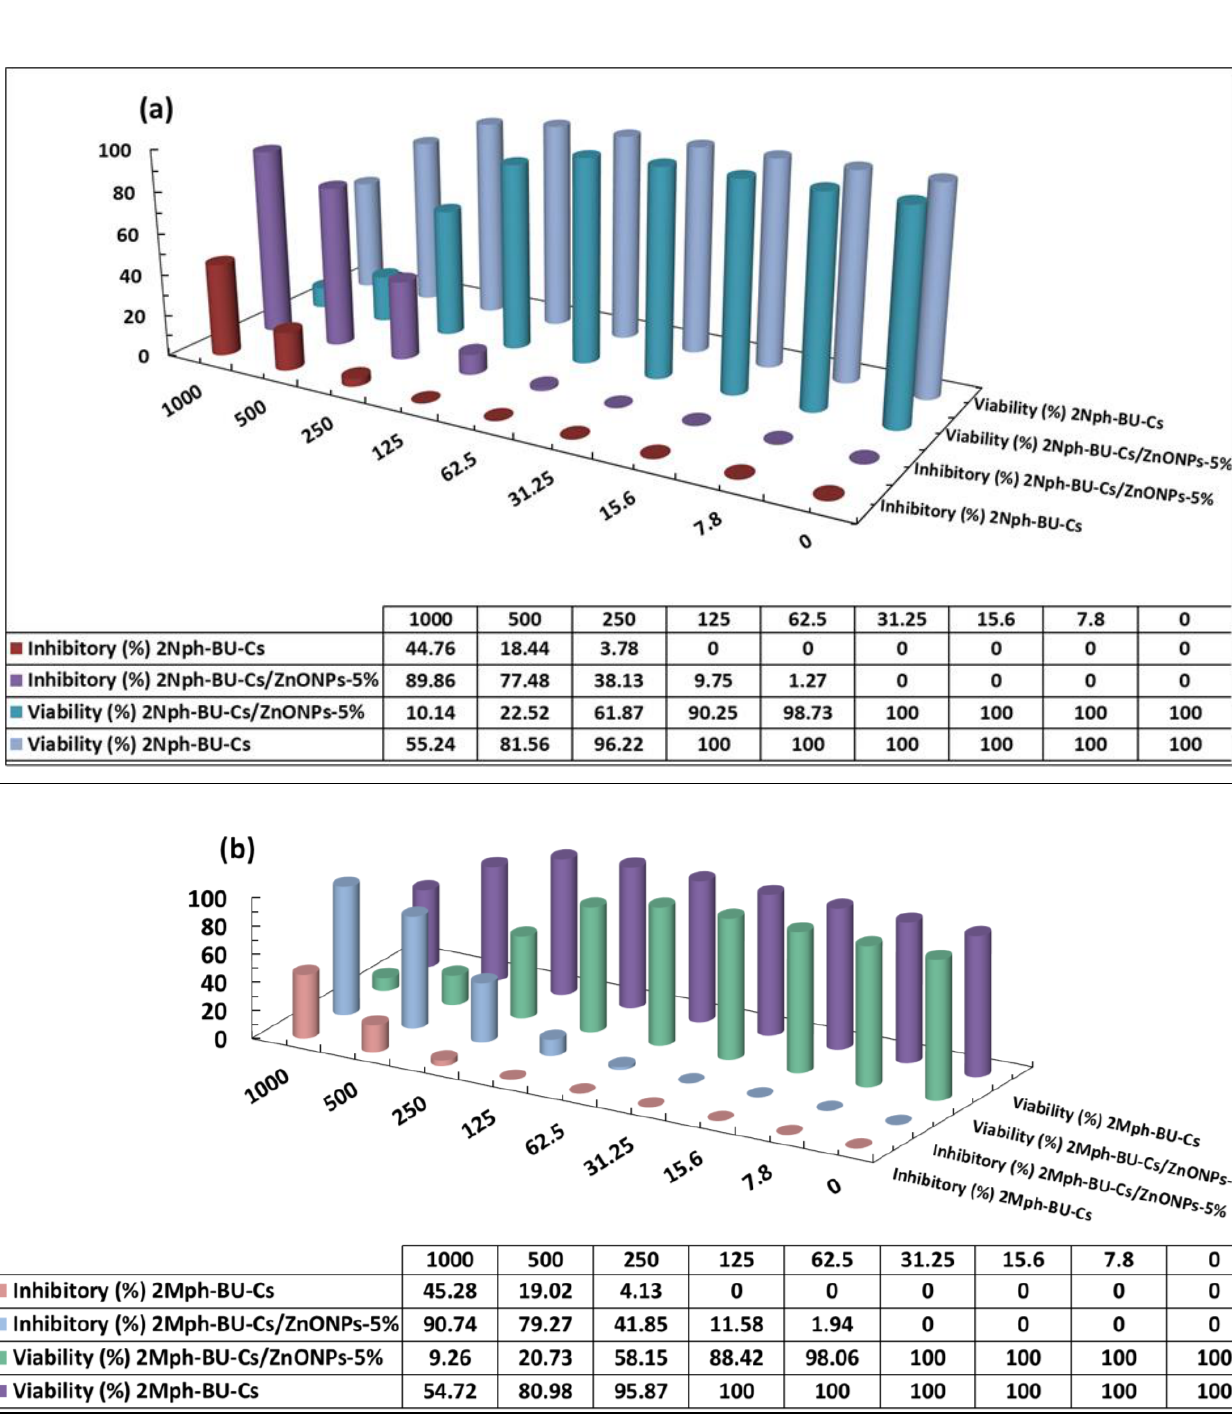
Figure 12. Cytotoxic impact of the prepared nano bio-composites on MRC-5 cells line: ( a ) 2Nph-BU-Cs/ZnONPs-5% and ( b ) 2Mph-BU-Cs/ZnONPs-5%.